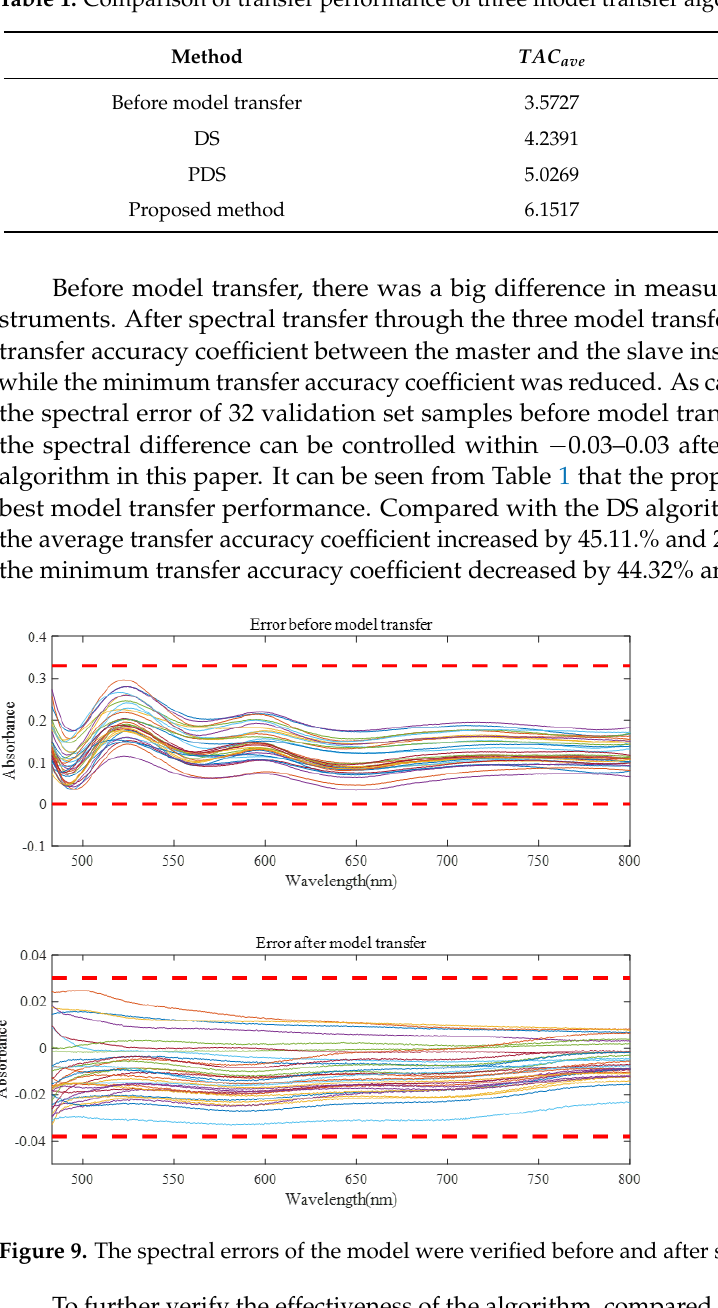
Table 1. Comparison of transfer performance of three model transfer algorithms.